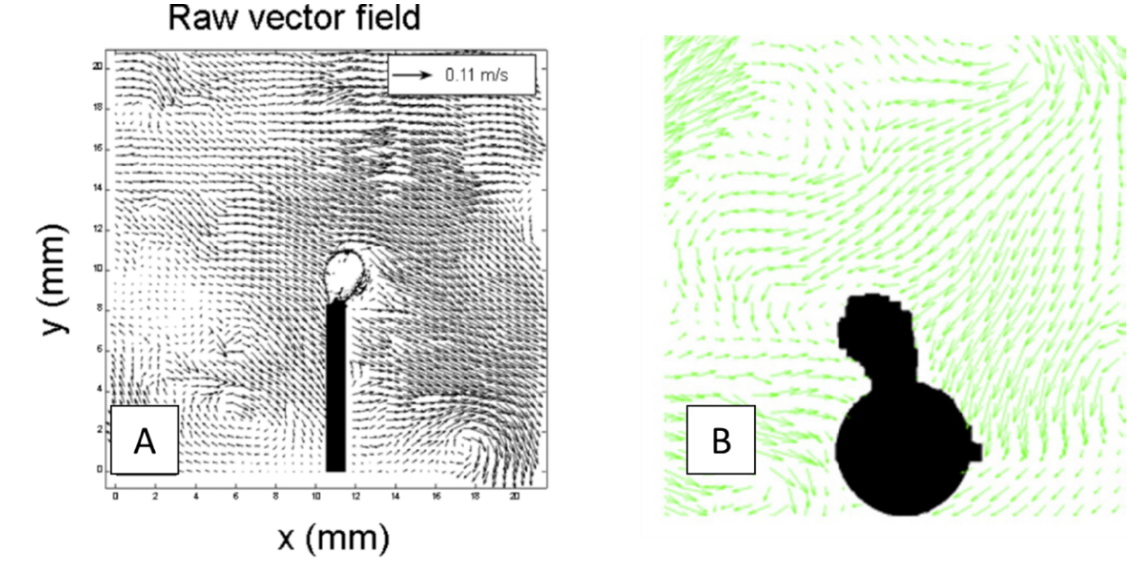
Figure 3. Instantaneous velocity field around a detaching bubble from ( a ) a cylinder [63] and ( b ) a sphere [64].